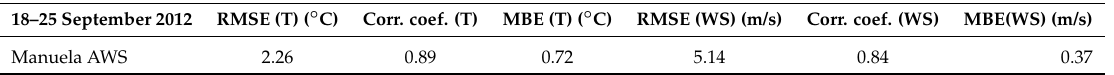
Table 2. Statistics for the comparison of AMPS results and AWS Manuela observations between 18 and 25 September 2012. T—temperature, WS—wind